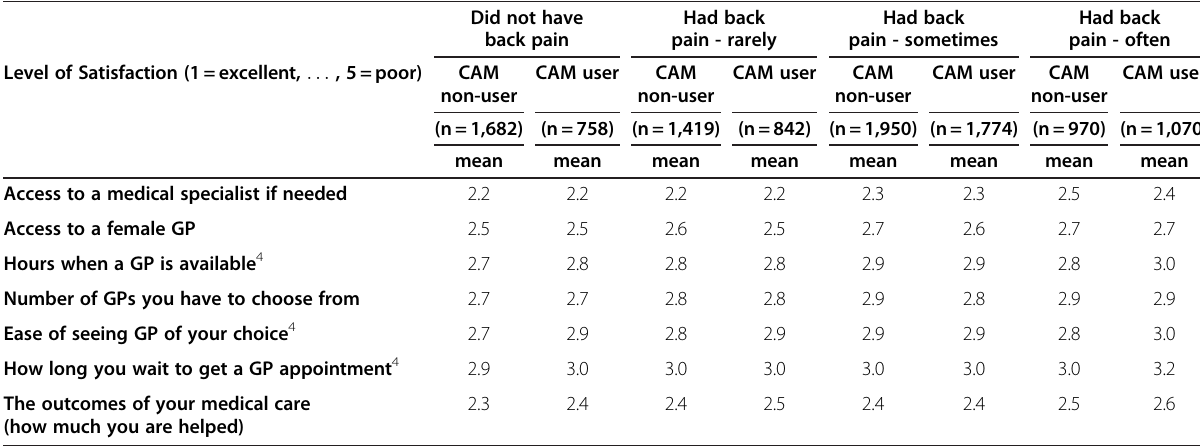
Did not have Had back Had back Had back back pain pain - rarely pain - sometimes pain - often